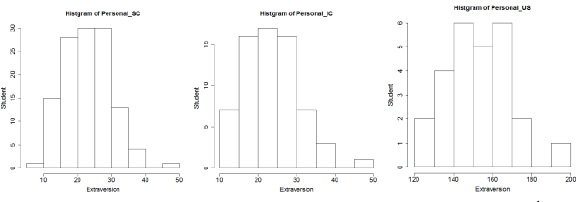
Figure 4. Histogram of Extraversion in each course (left: SDC, center: ITC, right: ODC)